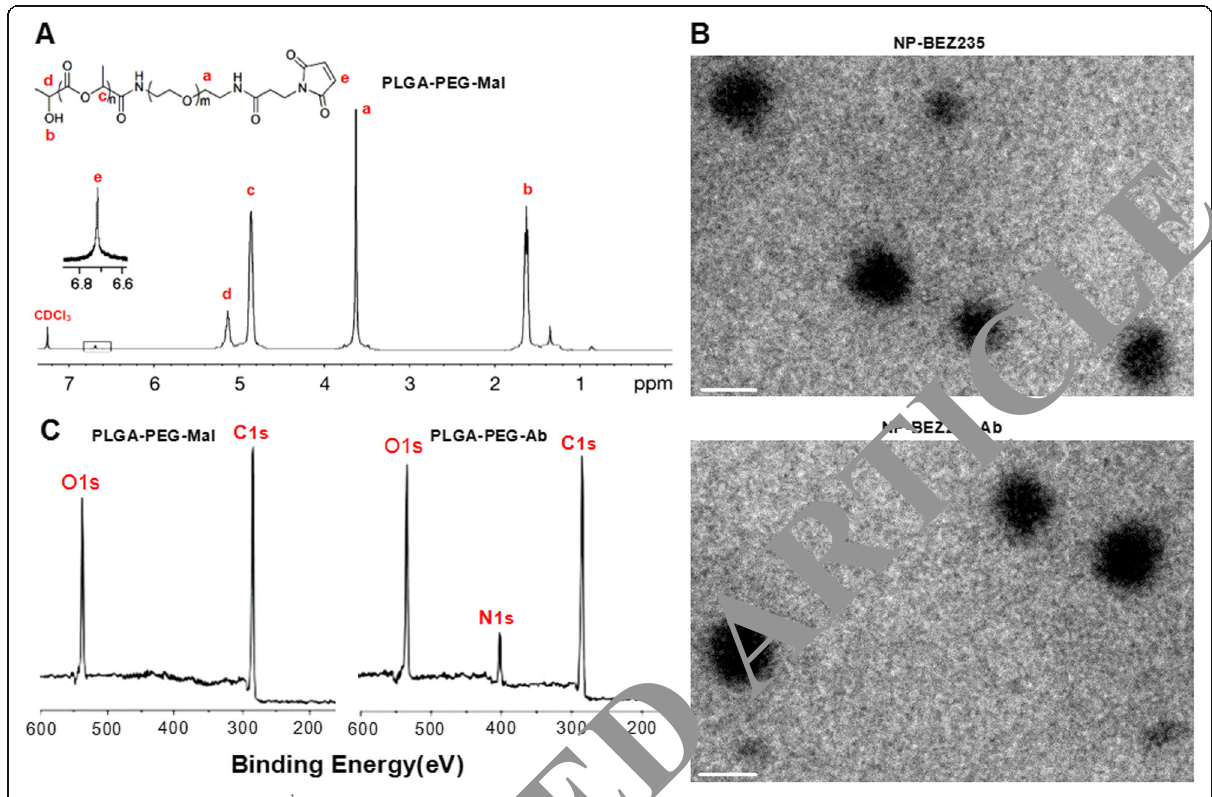
Fig. 1 Characterization of NPs. a 1 H nMR spectrum of PLGA-PEG-Mal; b TEM images of NP-BEZ235 and NP-BEZ235-Ab. The scale bar indicates 100 nM. c XPS spectrum of NP and NP-Ab. NPs, nanoparticles; 1 H-NMR, proton nuclear magnetic resonance; TEM, transmission electron microscopy; XPS, X-ray photoelectron spectroscopy; Mal, maleimide; PLGA, poly ( D , L -lactide-co-glycolide); PEG, poly (ethylene glycol); s, seconds